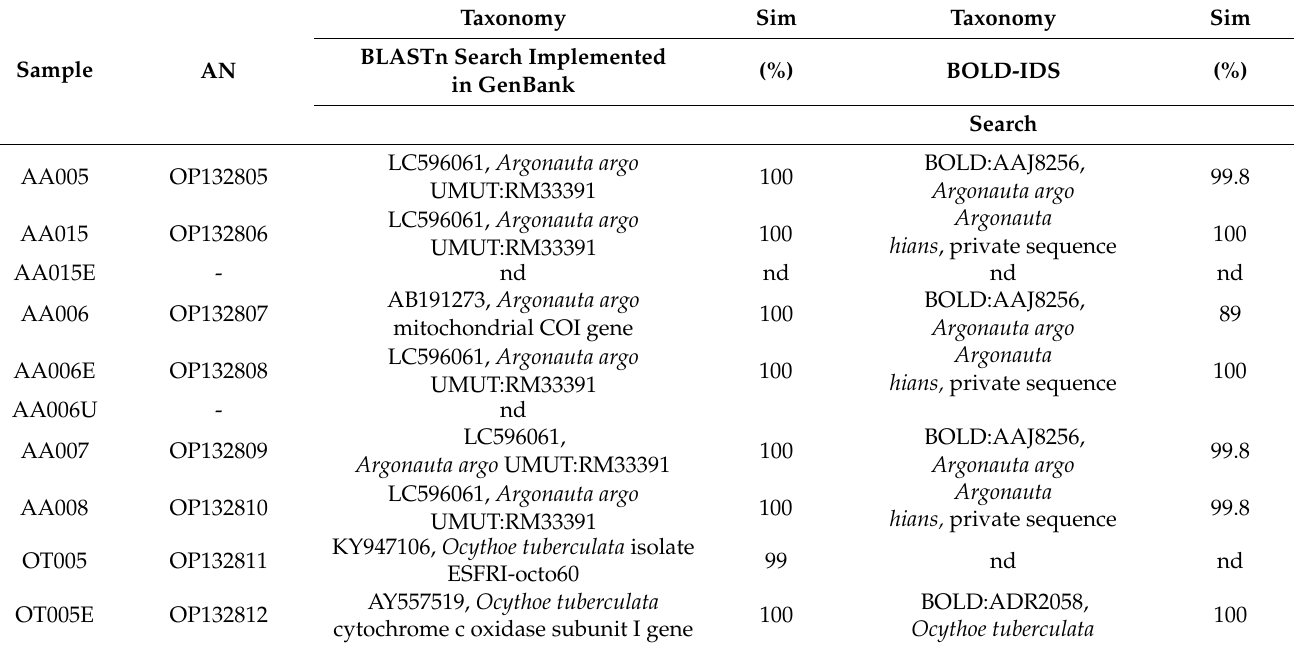
Table 2. Sample IDs, accession number and species identification assessed using the primer set